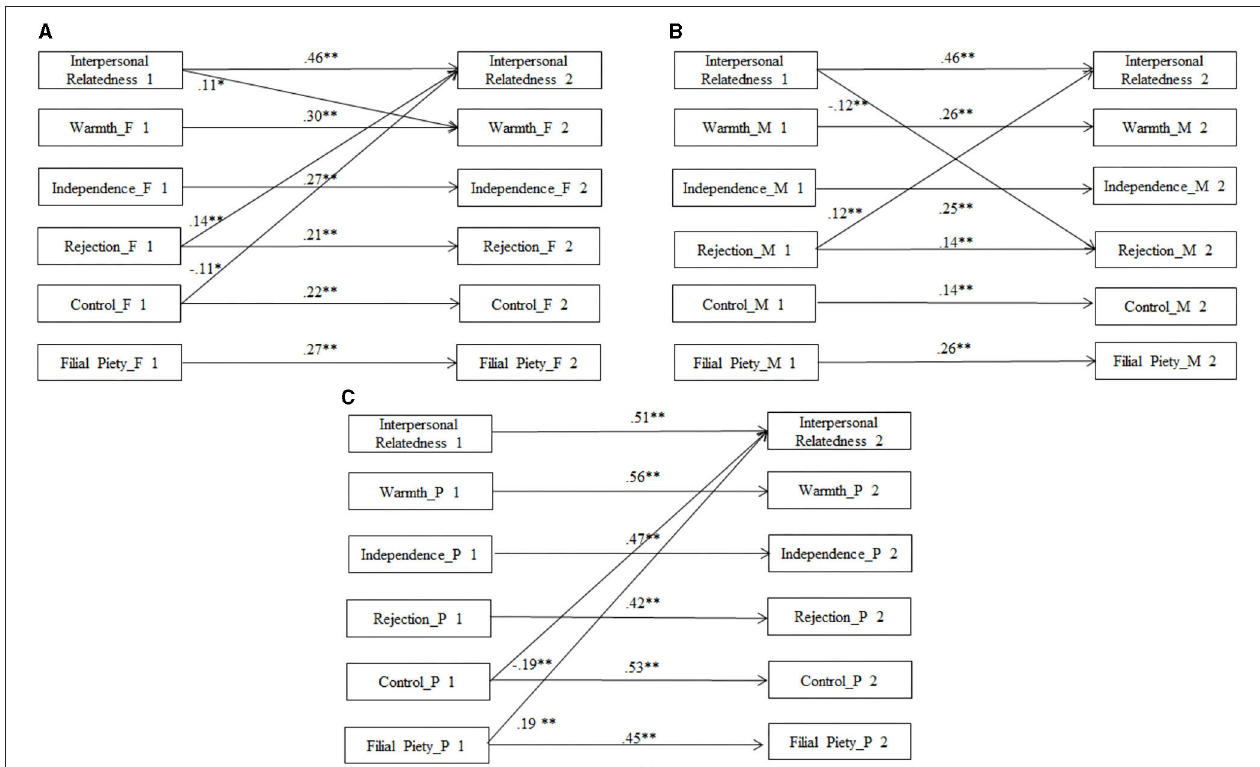
FIGURE 1 | Cross-lagged model of IR and parenting styles from grade 6 to grade 8: (A) paternal styles rated by adolescents, (B) maternal styles rated by adolescents, and (C) parenting style rated by parents. For clarity, the non-significant paths in within-time correlations are not reported. The figure following the variable name refers to the time point of data collection in this study. F, father; M, mother; P, parent. N is 652 for Model (A) , 615 for Model (B) , and 396 for Model (C) . * p < 0.05; ** p <